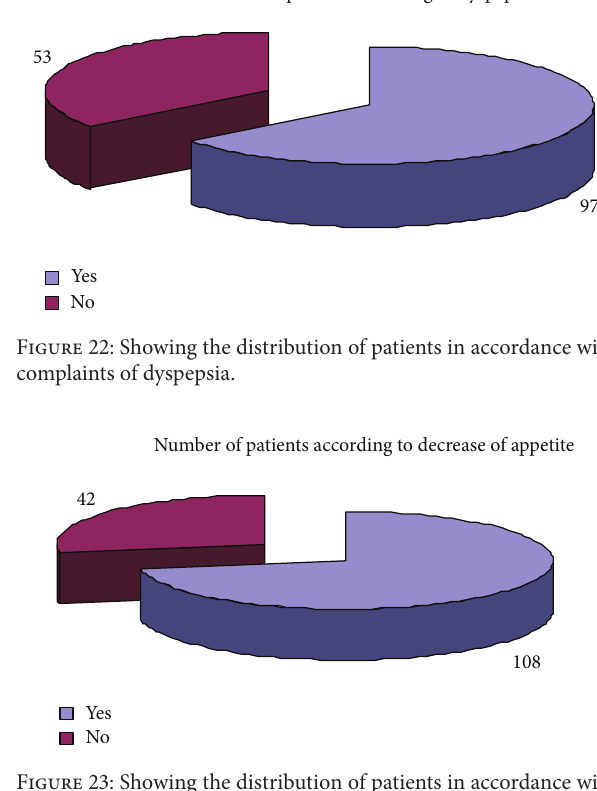
Figure 23: Showing the distribution of patients in accordance with complaints of decrease in appetite.